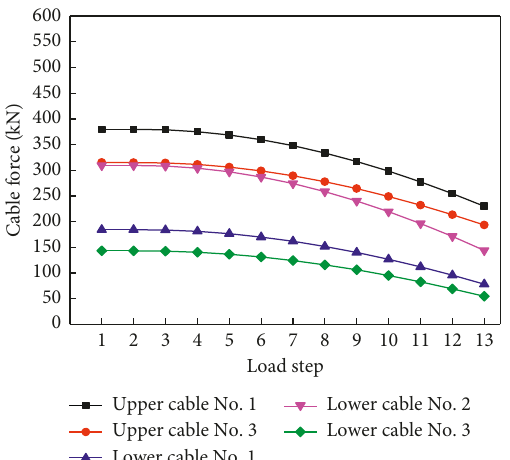
Figure 18: Calculated results of cable